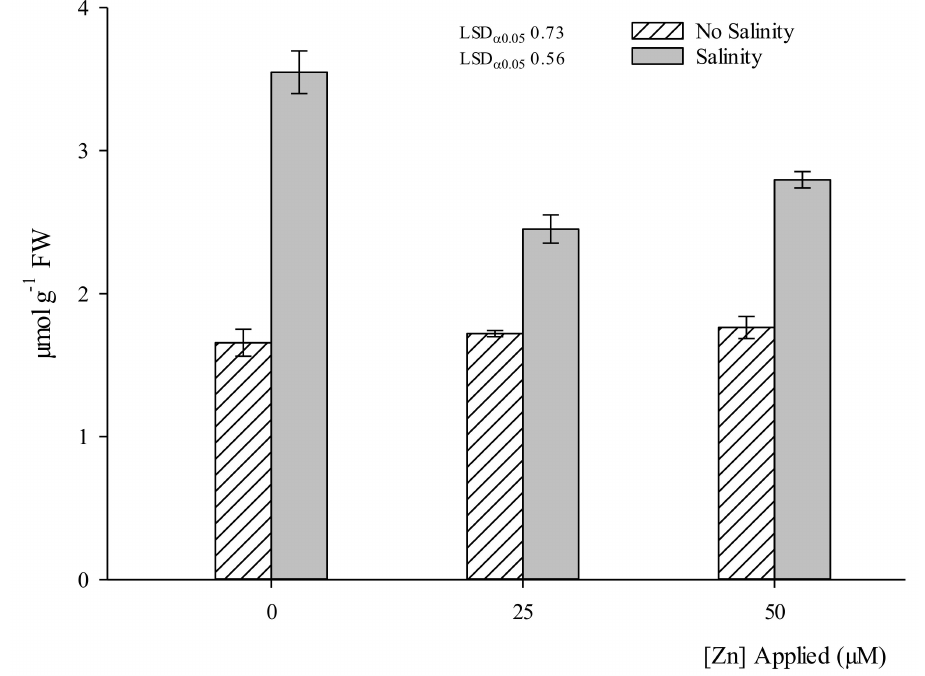
Figure 4. MDA concentration in pak choi roots subject to di ff erent salinity conditions and Zn foliar